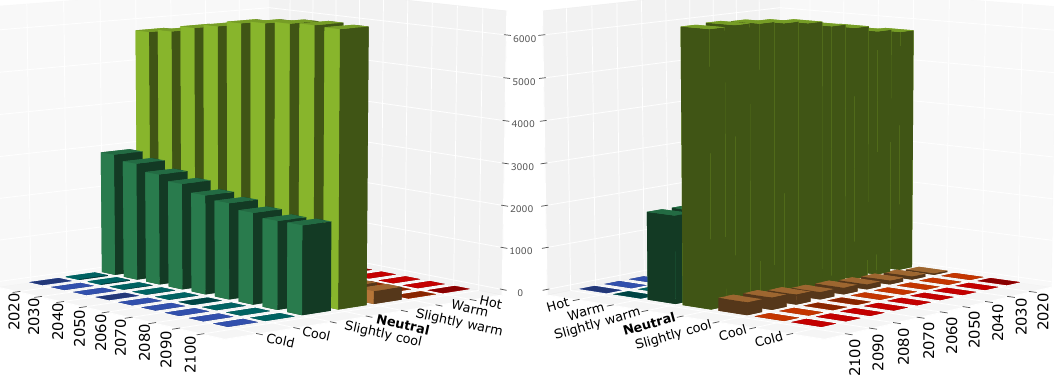
Figure A2. Comfort results taking into account the CTE-2013 standard and the Pamplona weather file generated with Meteonorm based on the IPCC scenario (1AB).